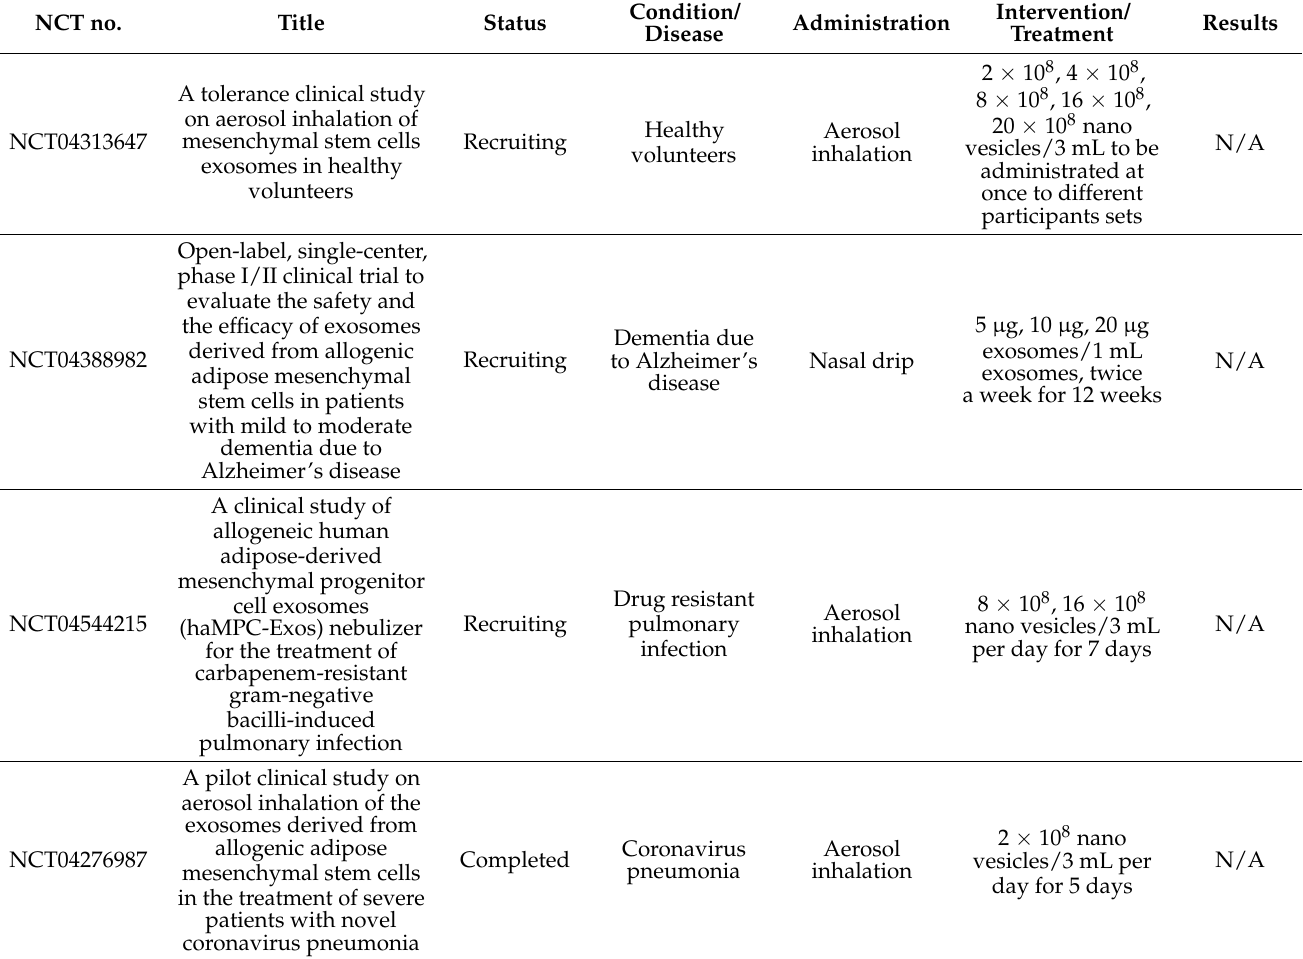
Table 1. Clinical trials of adipose-derived stem cells exosomes for cell-free based therapies. N/A—Not available [111]. NCT